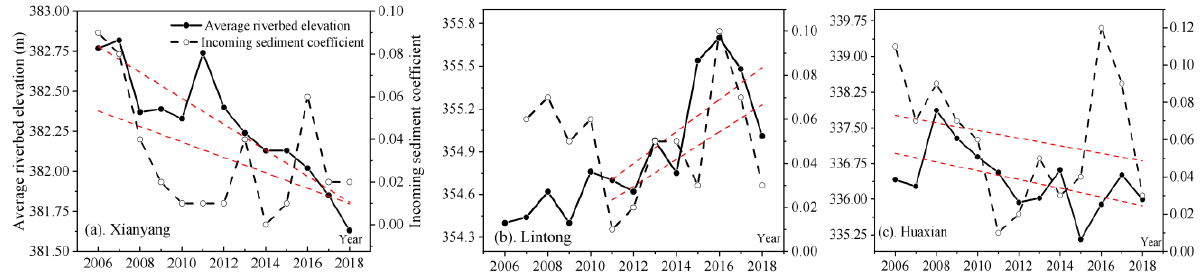
Figure 11. Comparison chart of average elevation and incoming sediment coefficient in the: (a) Xianyang station; (b) Lintong station; and (c) Huaxian station in 2006 – 2018.